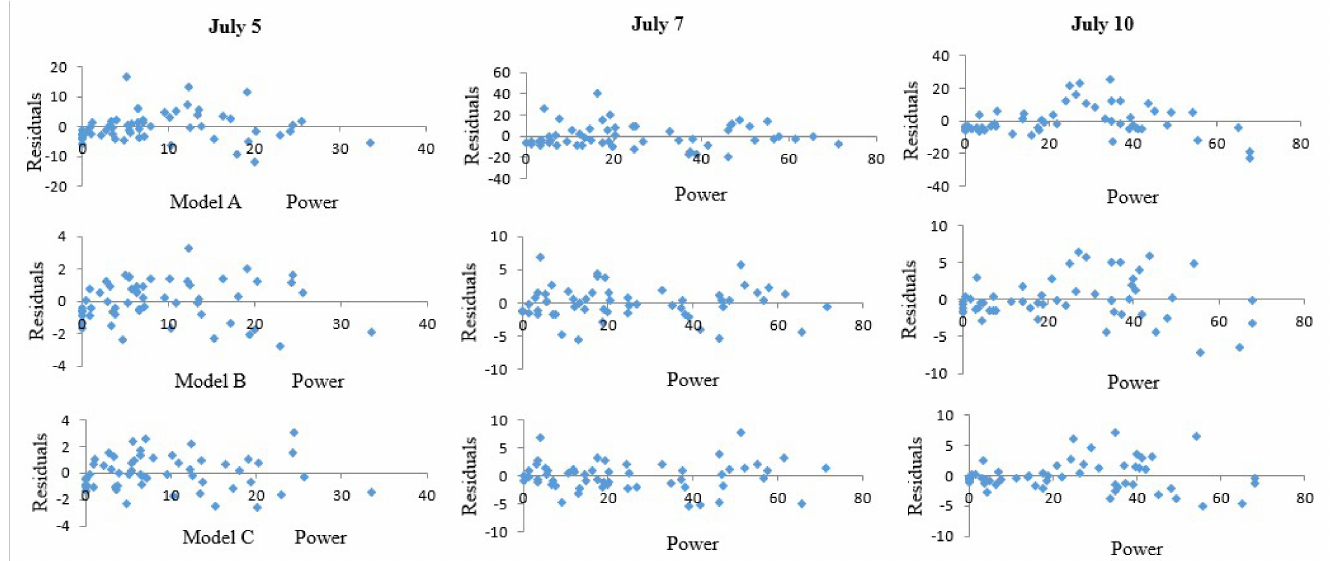
Figure 7. Prediction residual